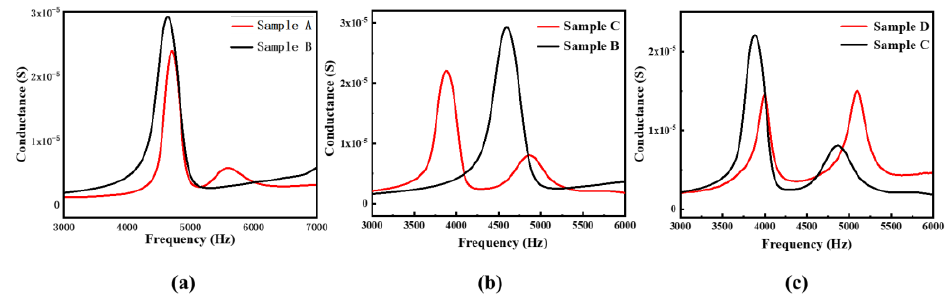
Figure 11. Test results of conductance curve. ( a ) The comparative conductance curves of Sample A and Sample B. ( b ) The comparative conductance curves of Sample B and Sample C. ( c ) The comparative conductance curves of Sample C and Sample D.